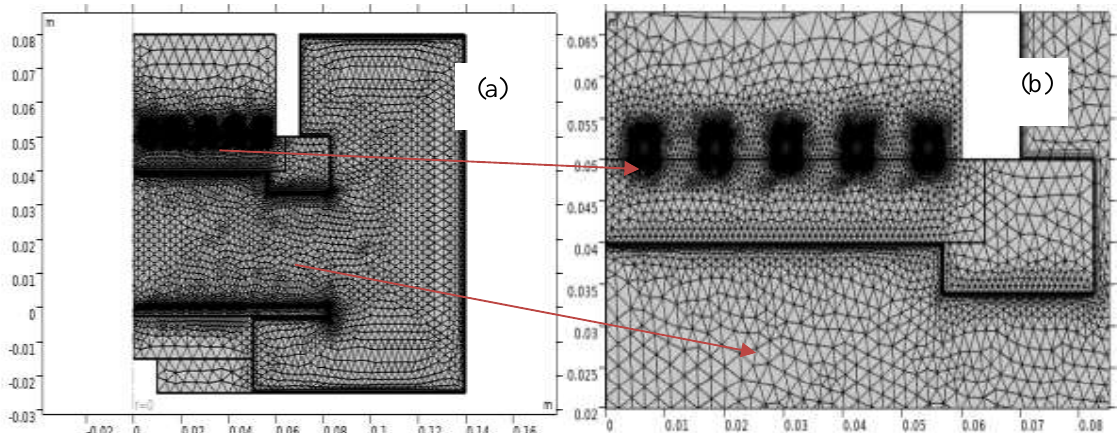
Figure 2: The domain meshing, a) total mesh, b) enlargement for the region of high- density